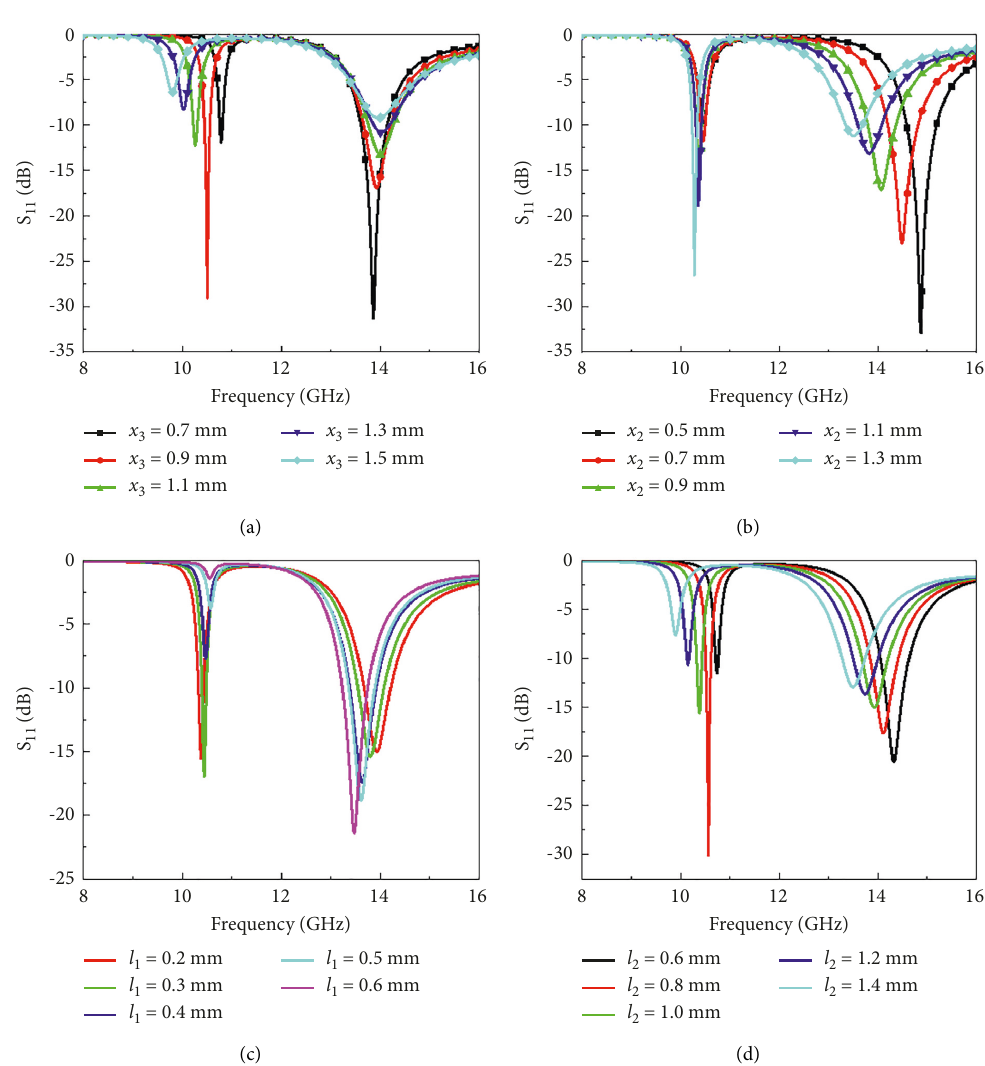
Figure 4: Simulated S